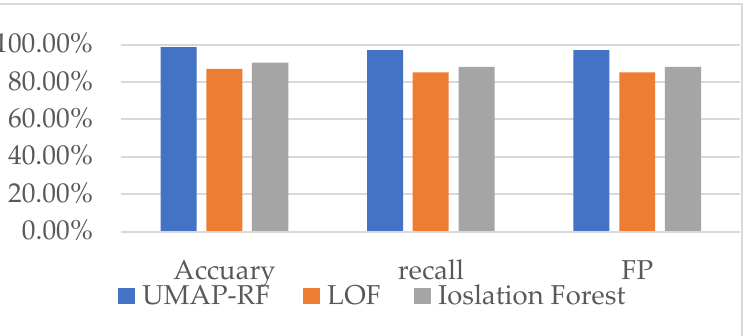
Figure 7. Comparison histogram of experimental results of different algorithms for KDDCUP dataset.